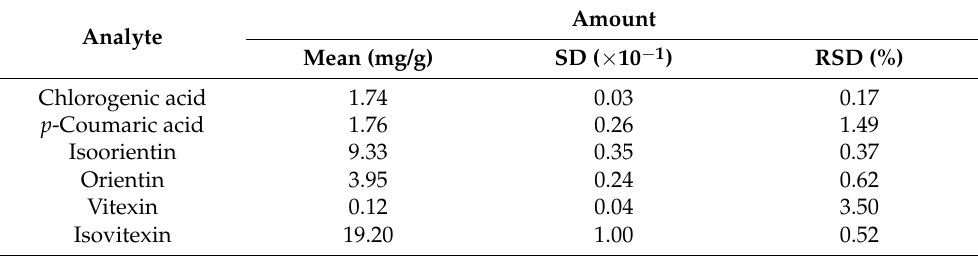
Table 9. Amounts of the six marker analytes in P. pubescens leaves determined by the LC–MS/MS MRM method ( n =